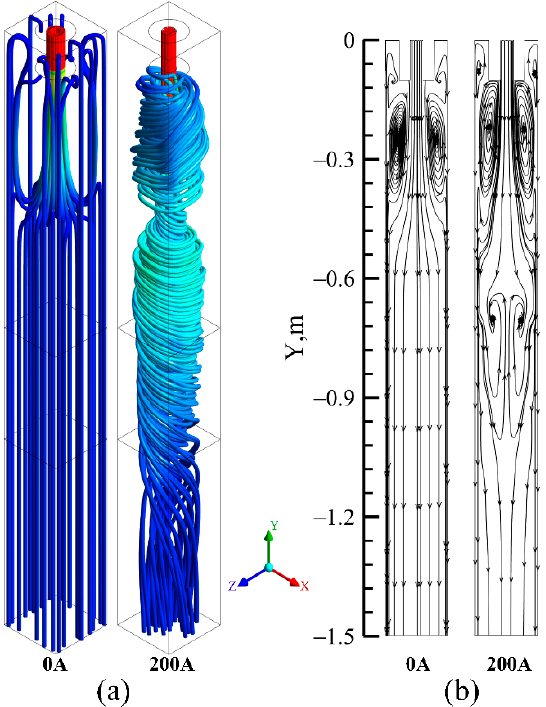
Figure 4. The streamline of fluid flow in continuous casting mold with M-EMS off ( I = 0 A) and on ( I = 200 A 4 Hz): ( a ) 3D, ( b ) 2D at the plane Z = 0.